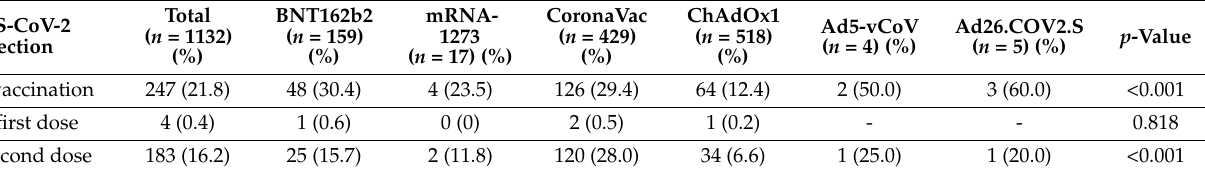
Table 4. SARS-CoV-2 infection